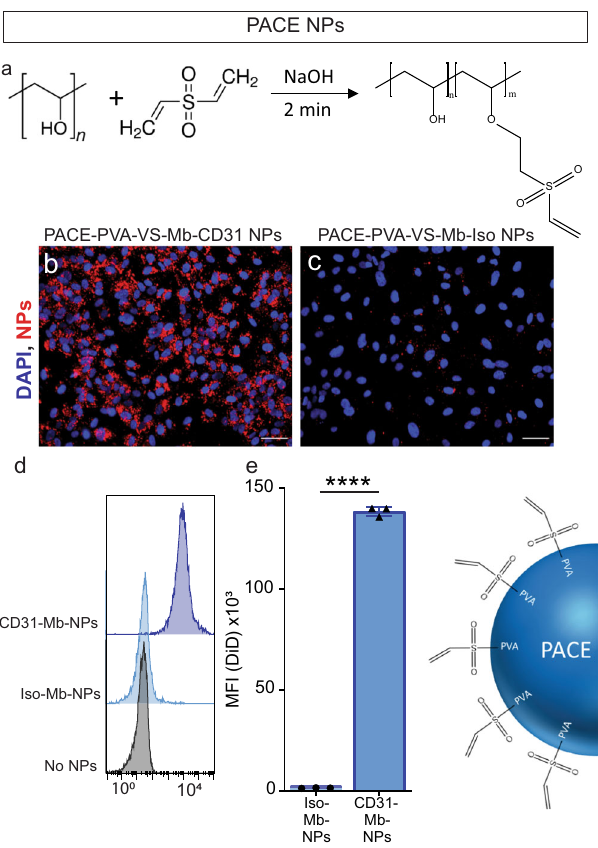
Fig. 4 | The monobody adapter is compatible with nanoparticle systems pre- pared by emulsion-evaporation using poly(vinyl alcohol-vinyl sulfone). a Schematic of the reaction to prepare poly(vinyl sulfone). Fluorescent images of humanumbilicalveinendothelialcells(HUVECs)treatedinvitrowithPACE-PVA-VS- Mb-CD31 NPs ( b ) or PACE-PVA-VS-Iso NPs ( c ). Scale bars, 50 μ m. The cell nuclei were stained with DAPI, depicted in blue. The NPs are depicted in red. d Representative fl ow cytometry histograms and e mean fl uorescence intensity (MFI) values of fl uorescent Ab-Mb-PACE-NP bound to HUVECs in vitro (error bars represent SD). Each data point represents the averaged from three wells with 10,000 HUVECs captured/well ( n =at least three independent experiments). Sta- tisticalsigni fi cancebetweentreatmentsisdenoted with**** p <0.001,byamultiple two-tailed T -tests with a Bonferroni correction. Data are presented as mean values+/ − SD. Source data are provided as a Source Data fi le. PACE Poly(amine-co- ester), PVA Poly(vinyl alcohol), VS vinyl sulfone, NP nanoparticle, Ab antibody, iso isotype Ab, Mb